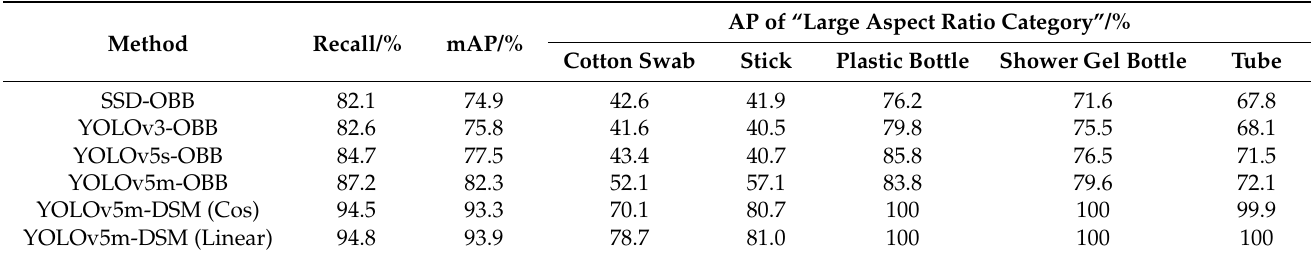
Table 1. Comparison between YOLOv5m-DSM and horizontal frame detection